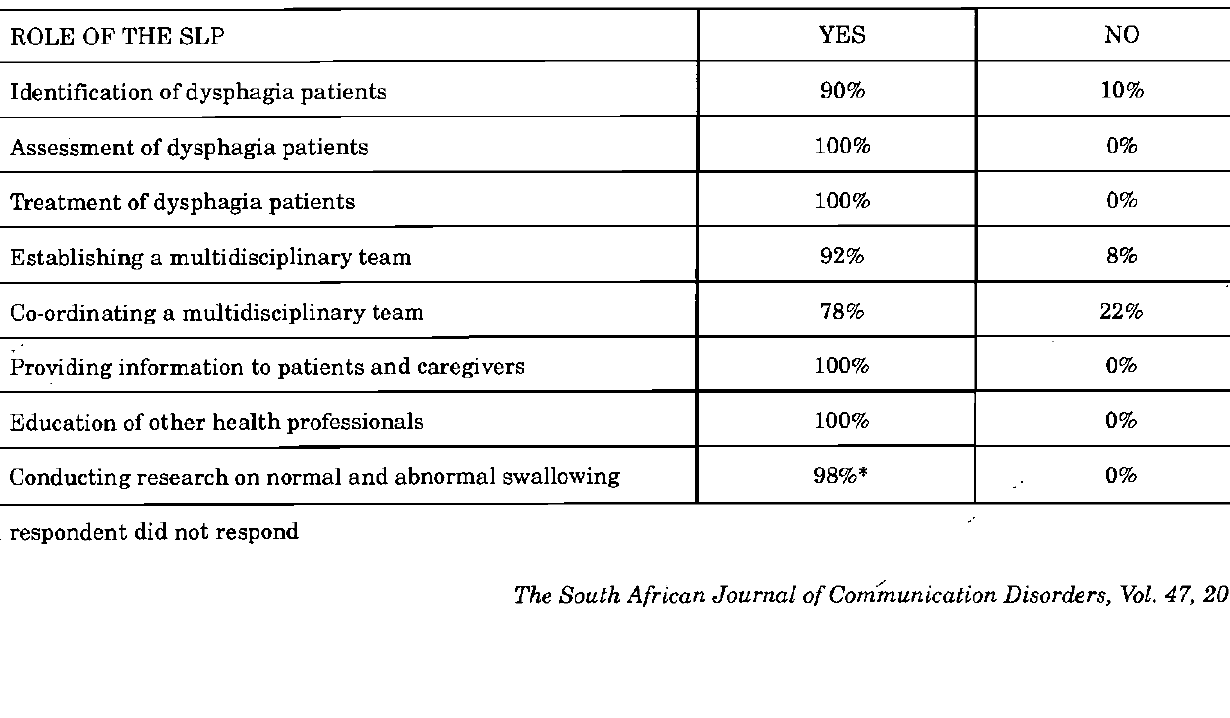
TABLE 6: Role of the Speech-Language Pathologist in Dysphagia ROLE OF THE SLP Identification of dysphagia patients